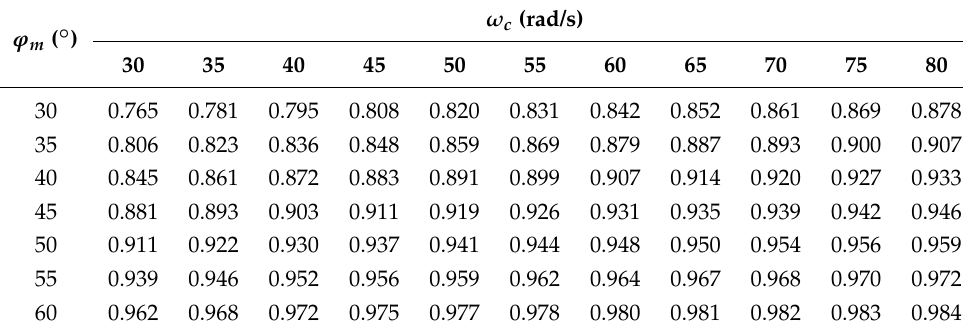
Table 1. Look-up table of the derivative order µ for different design specifications. ϕ m ( ◦